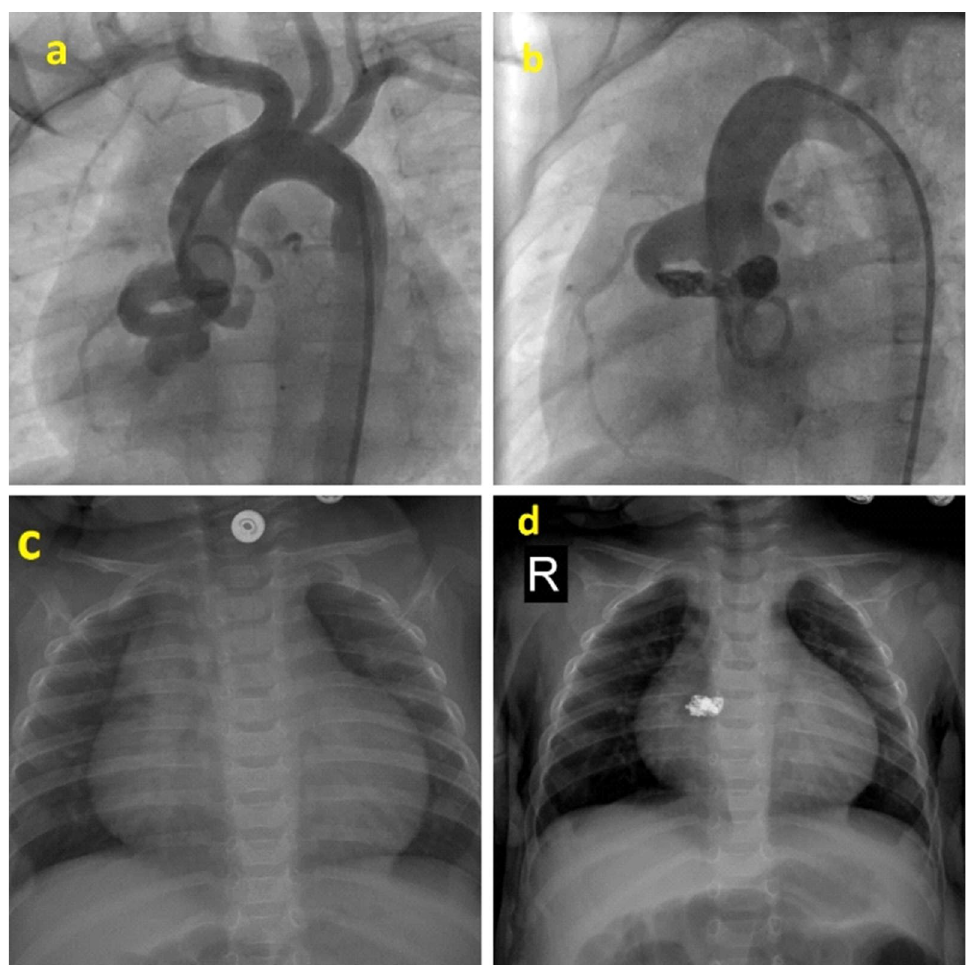
Fig. 1 Fistula between RCA and RA which has been closed with 2 PFM coils via retrograde approach. a , b ; Dilated fistula between RCA and RA, which has been closed with 2 pfm coils via retrograde approach. c , d ; Reduced CT/ratio after the coil